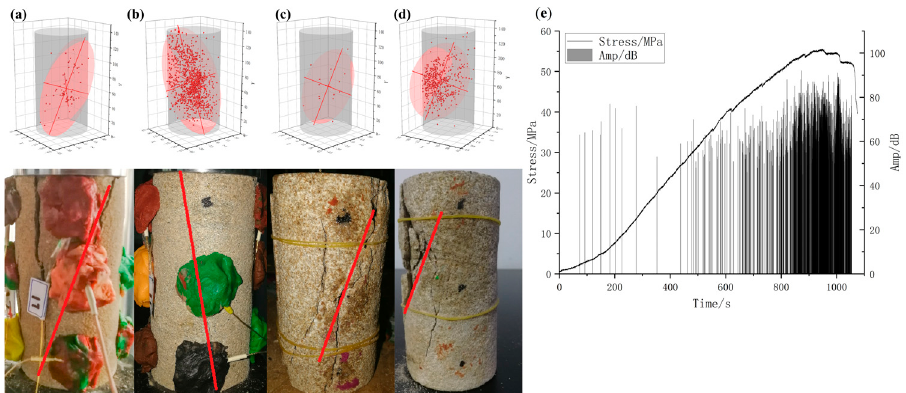
Figure 4. The results of loading and AE monitoring. ( a ) Results for specimen S2 failure and its 71 AE events. ( b ) Results for specimen S3 and its 1069 events. ( c ) Results for specimen S4 and its 14 AE events. ( d ) Results for specimen S5 and its 469 events. ( e ) Variation in stress and event amplitude in specimen S3.